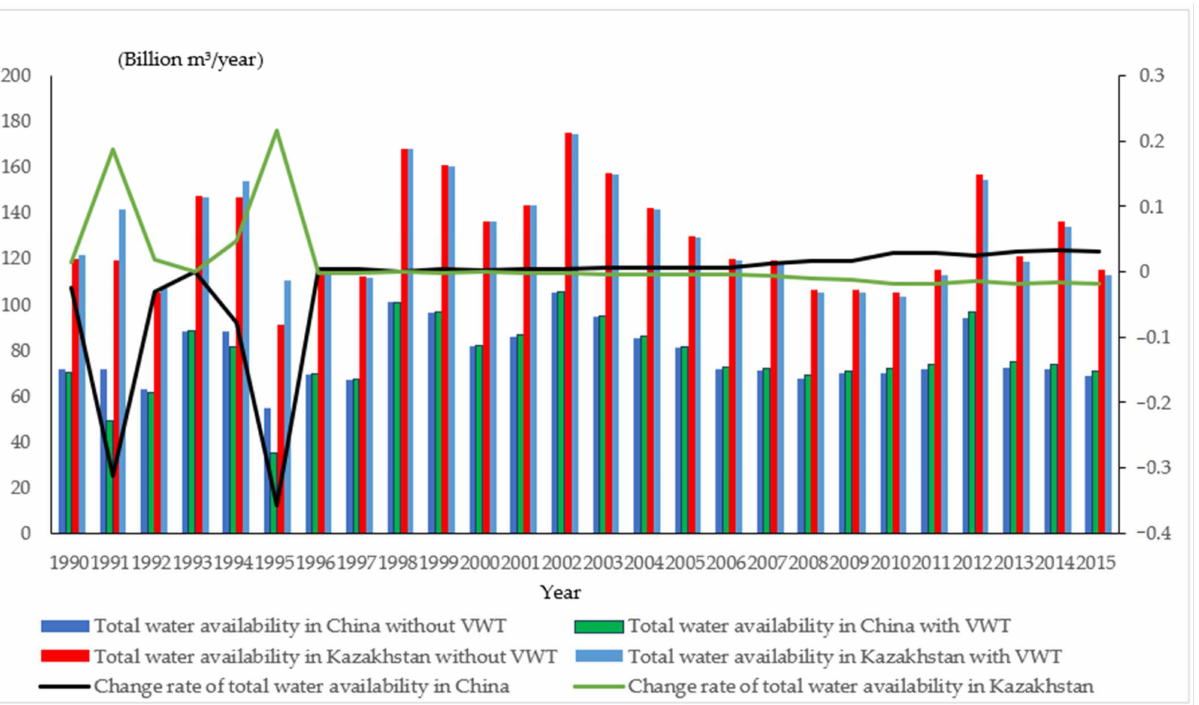
Figure 6. Changes in the total water availability in the study area under both